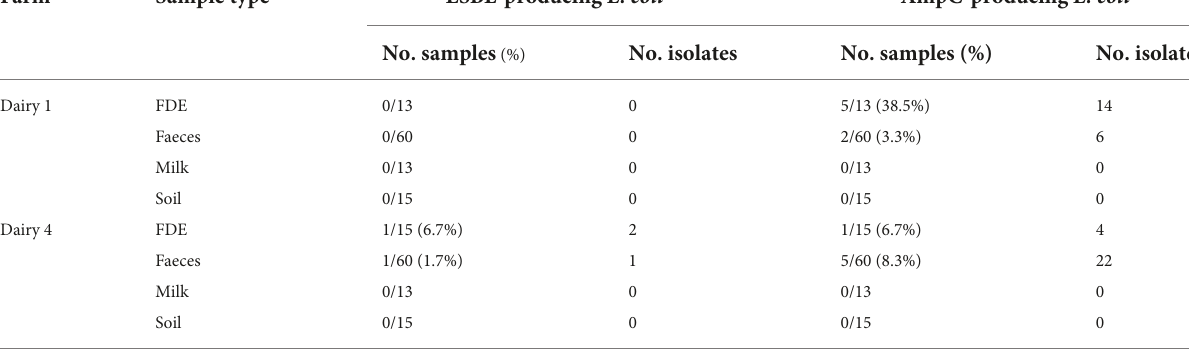
TABLE 1 Number of positive ESBL- and AmpC-producing Escherichia coli samples and